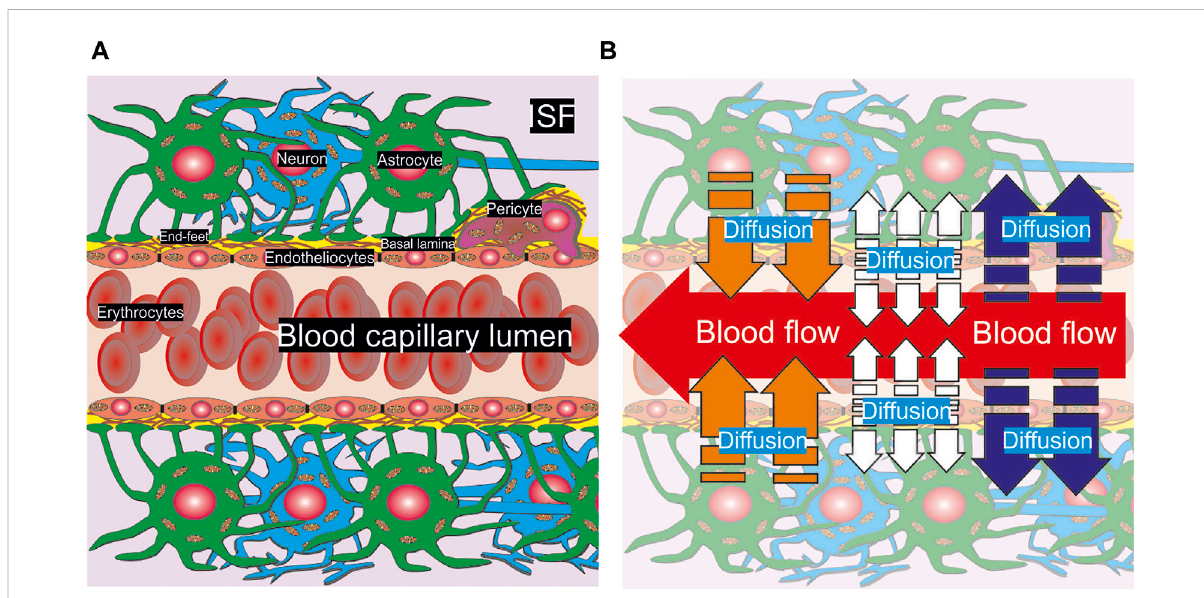
FIGURE 1 A scheme of anatomical composition of NVU. A part of a capillary pipe with erythrocytes included inside is surrounded by basal lamina, a pericyte,astrocytesandneurons (A) .Thecellsarepicturedwiththenucleusandmitochondria.End-feetarerepresentedasthetouchareanearbasal lamina and the pericyte. The physical processes of convection and diffusion are shown in appropriate areas of NVU (B) . A convectional CBF is represented as a red arrow in the capillary lumen. The diffusion of nutrients out/into the blood stream is indicated by blue and orange arrows respectively. The diffusion from the endothelium is marked by white